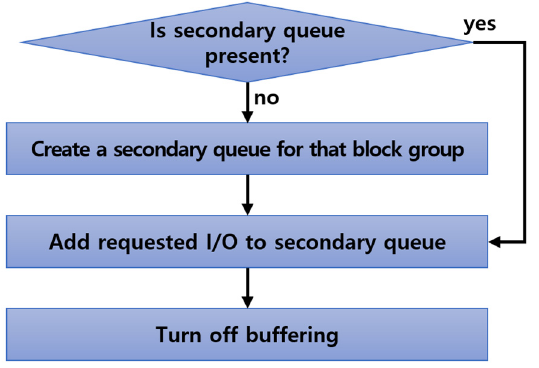
Figure 7. I/O buffering step.